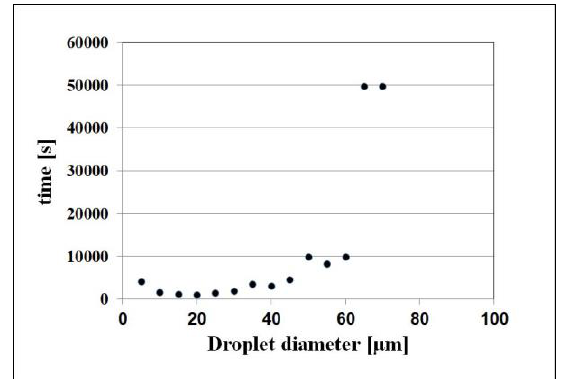
Fig. 4. The time, for which a drop of appropriate diameter, will definitely appear in the probe.